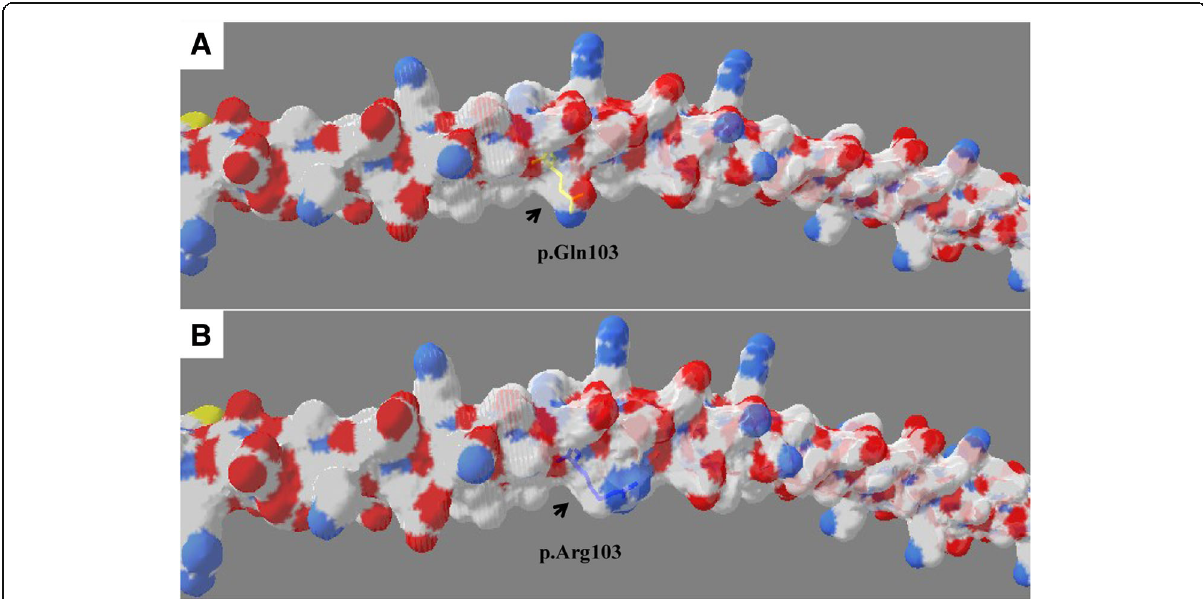
Fig. 5 SWISS-MODEL prediction of the p.Q103R mutation in tropomyosin. a The 3-dimensional structure of wild-type tropomyosin with position 103 indicated by a black arrow. Nearby acidic (red) and basic (blue) surface properties are illustrated with the neutral glutamine residue shown as a yellow line. b Acidic surface properties are destroyed with the substitution of basic arginine for glutamine. The substitution is depicted as a blue